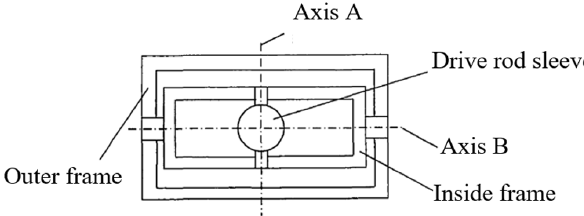
Figure 2. Hooke joint structure